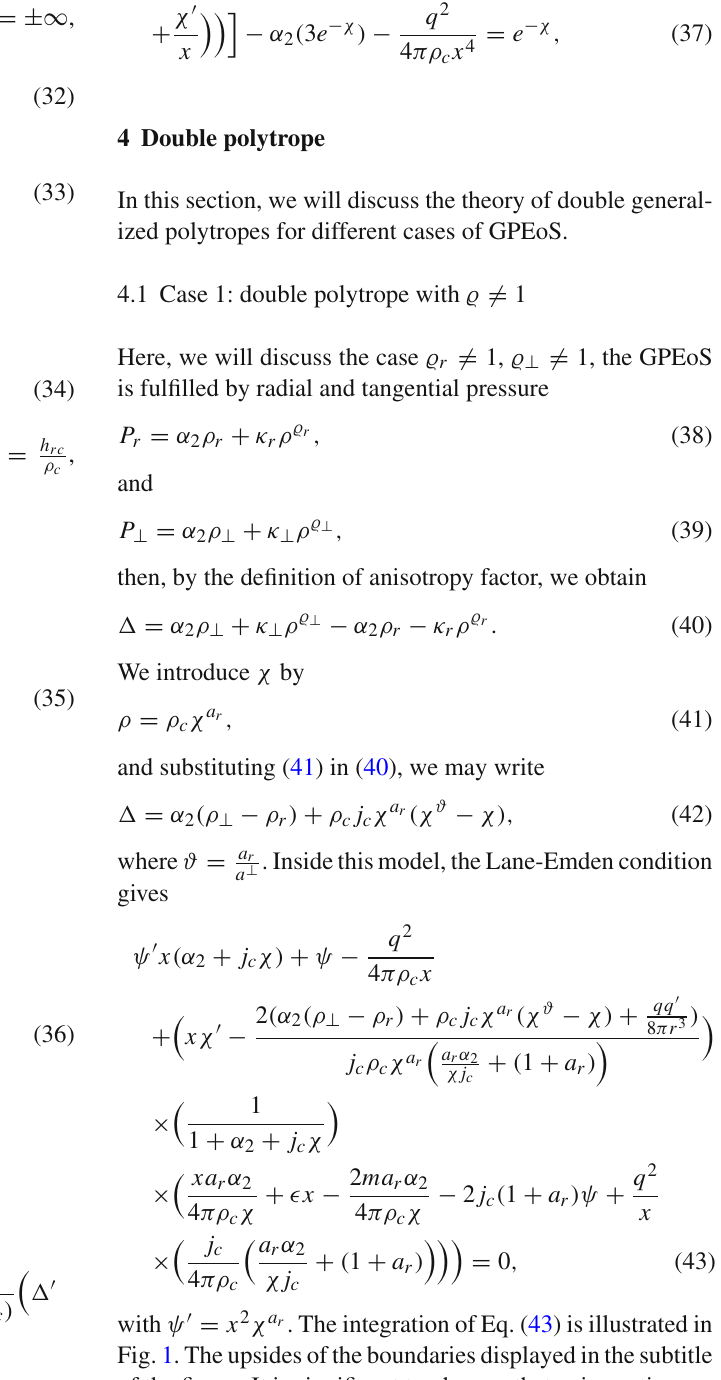
Fig. 1. The upsides of the boundaries displayed in the